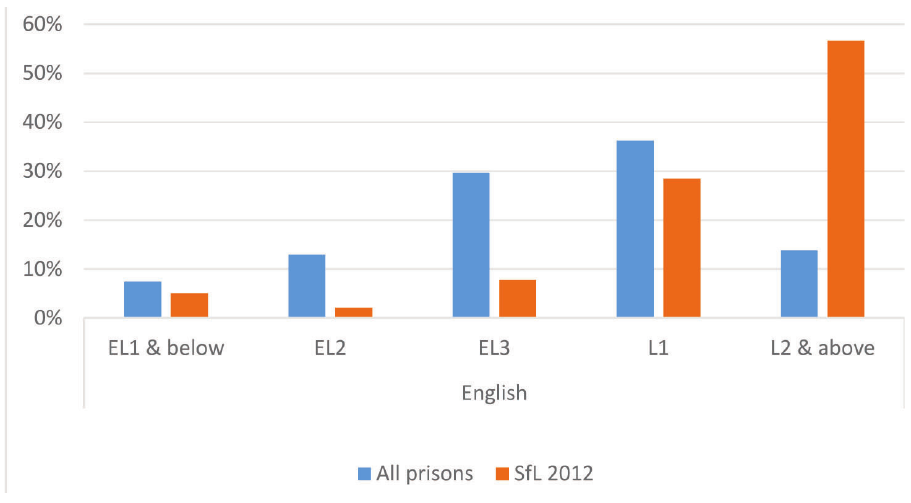
Figure 1: Prisoners’literacylevelscomparedwiththe2011SkillsforLife(SfL)survey